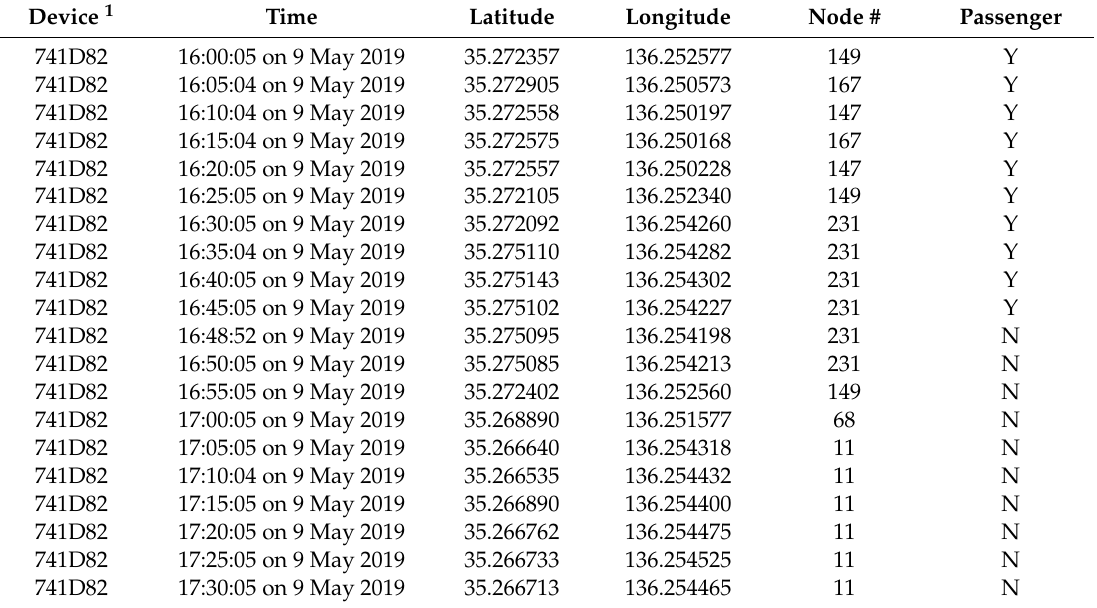
Table 1. Examples of rickshaw datasets detected by our electronic device and stored in cloud server. Device